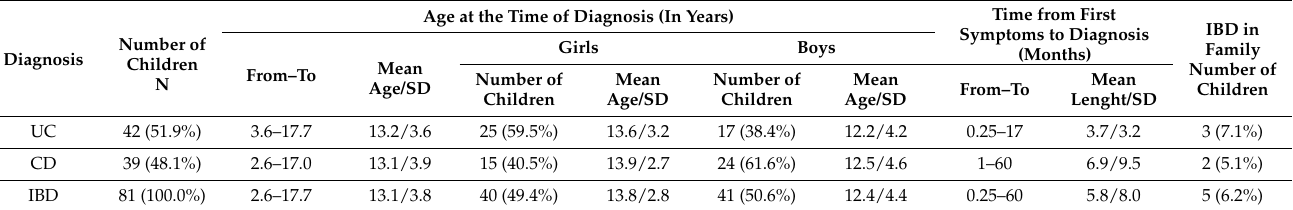
Table 1. Age, gender, and time to diagnosis.